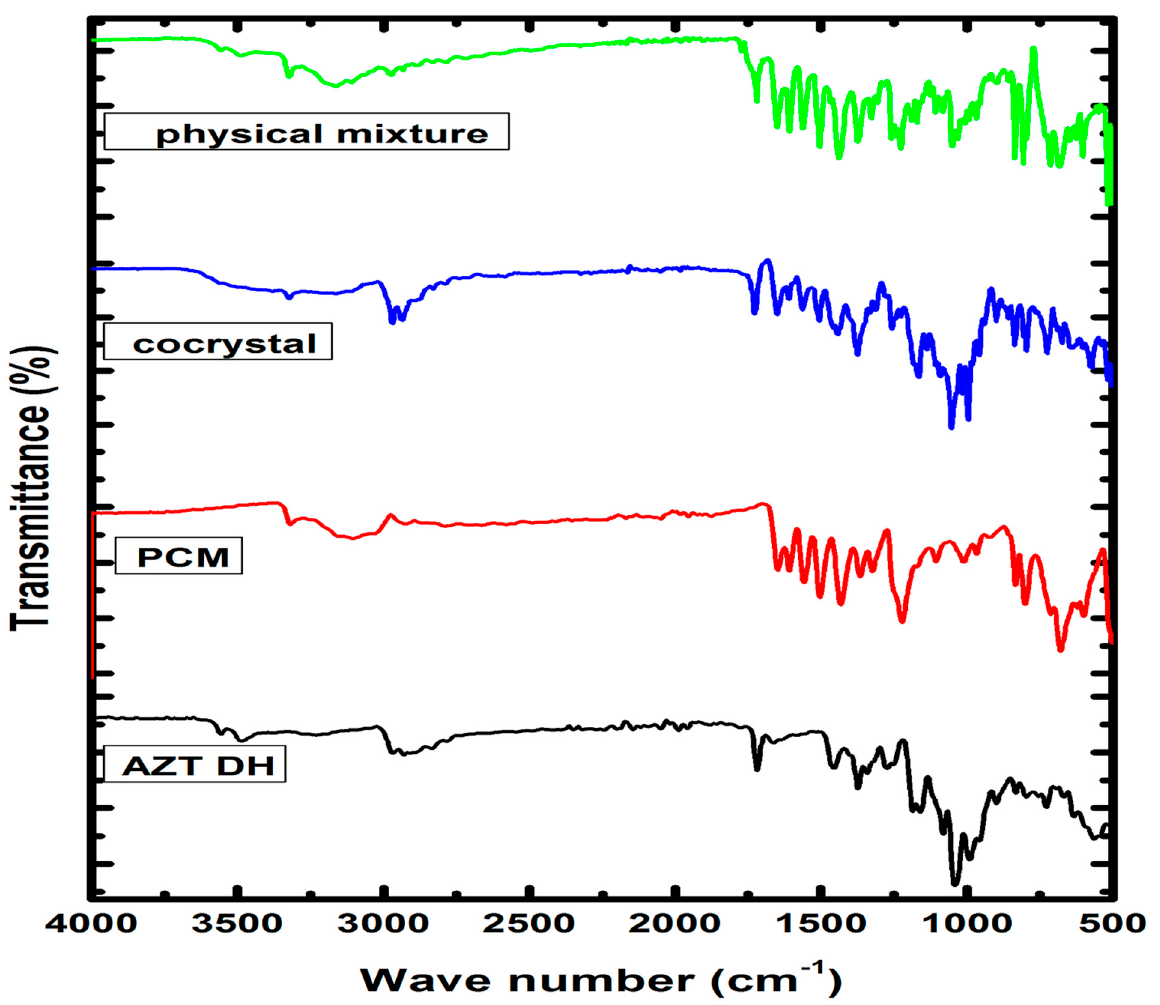
Figure 3. FTIR spectra of AZT DH, PCM, cocrystal and physical mixture. . Due to the complex FTIR spectrum of cocrystal (AZT-PCM) the unambiguous assign- ment of peaks is very tough task. However, attenuation, broadening and slight change in position of peaks can give a hint for Van der Waals interactions [49,50]. An abnormally broad peak formed in the region of 3600–3015 cm − 1 indicates some new set of H-bond interactions [51,52], while no such peak formation is observed in the physical mixture spectrum. The OH of PCM is involved in intermolecular hydrogen bonding with N in pure solid state while in cocrystal the OH stretching peak (3319 cm − 1 ) and NH bending peak (1557 cm − 1 ) of PCM have shifted to 3327 and 1565 cm − 1 , respectively. The peak of AZT DH shifted from 1718 to 1727 cm − 1 may be due to the involvement of C=O functional group in H-bonding, where slight shift of electrons density and deduction of bond order can be observed. From 1718–1458 cm − 1 , the AZT DH remains inactive [53] where several charac- teristic peaks that correspond to PCM appeared in this region [36]. An overall inspection of spectrum indicates the existence of PCM and shifting of OH and NH peaks revealed the establishment of hydrogen bonding with AZT. Moreover, slight shifting in wave number values of peaks was also observed in the fingerprint region. From the above discussion it is strongly suggested that AZT and PCM interact through non-covalent interactions with each other to afford cocrystals. Furthermore, both drugs showed compatibility with each other because all characteristic peaks of both components appeared in the FTIR spectrum of the resulted cocrystal (Figure